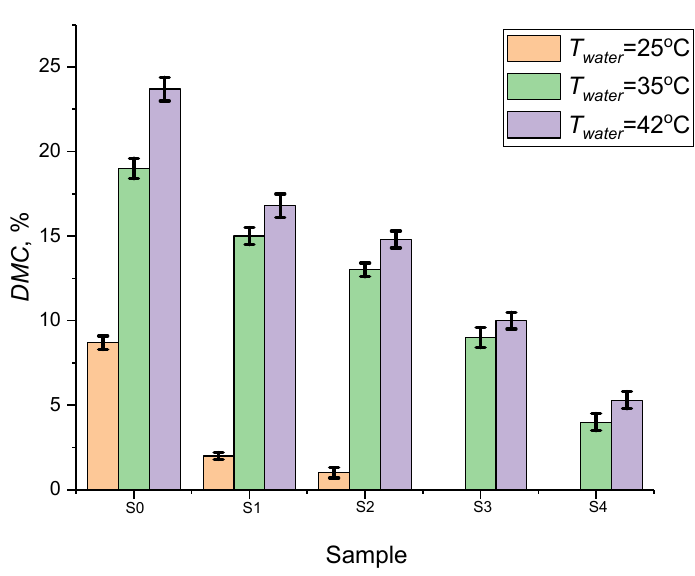
Figure 12. Results of sample masses change after 10 days in aqueous medium.